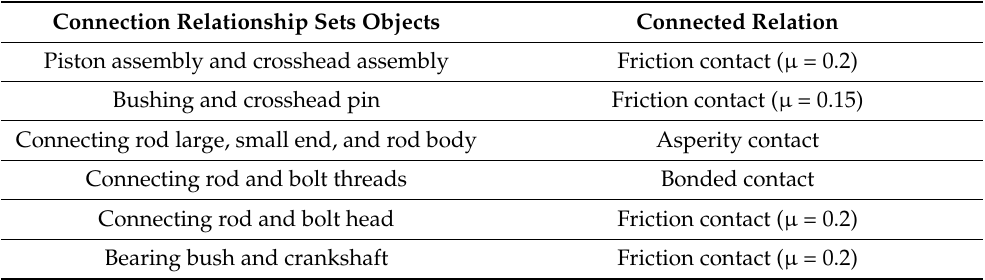
Table 3. Construction of connection relation in simulation calculation of connecting rod assembly.